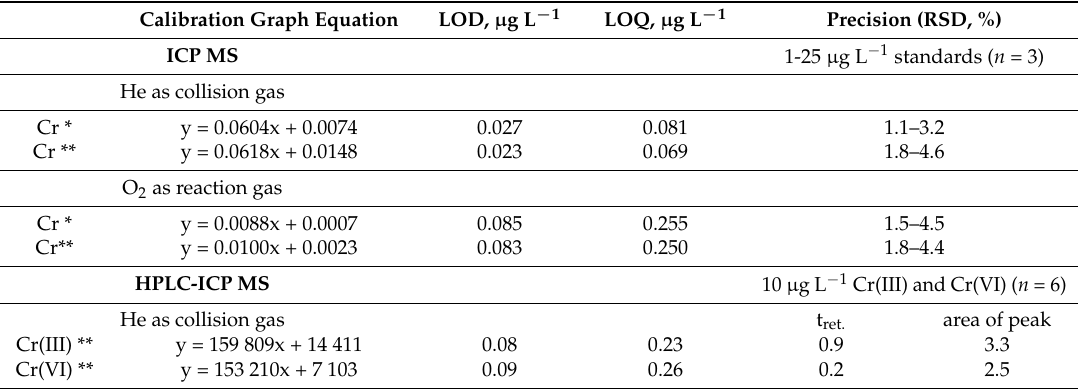
Table 2. Analytical characteristic of ICP MS and IP RP-HPLC-ICP MS methods.